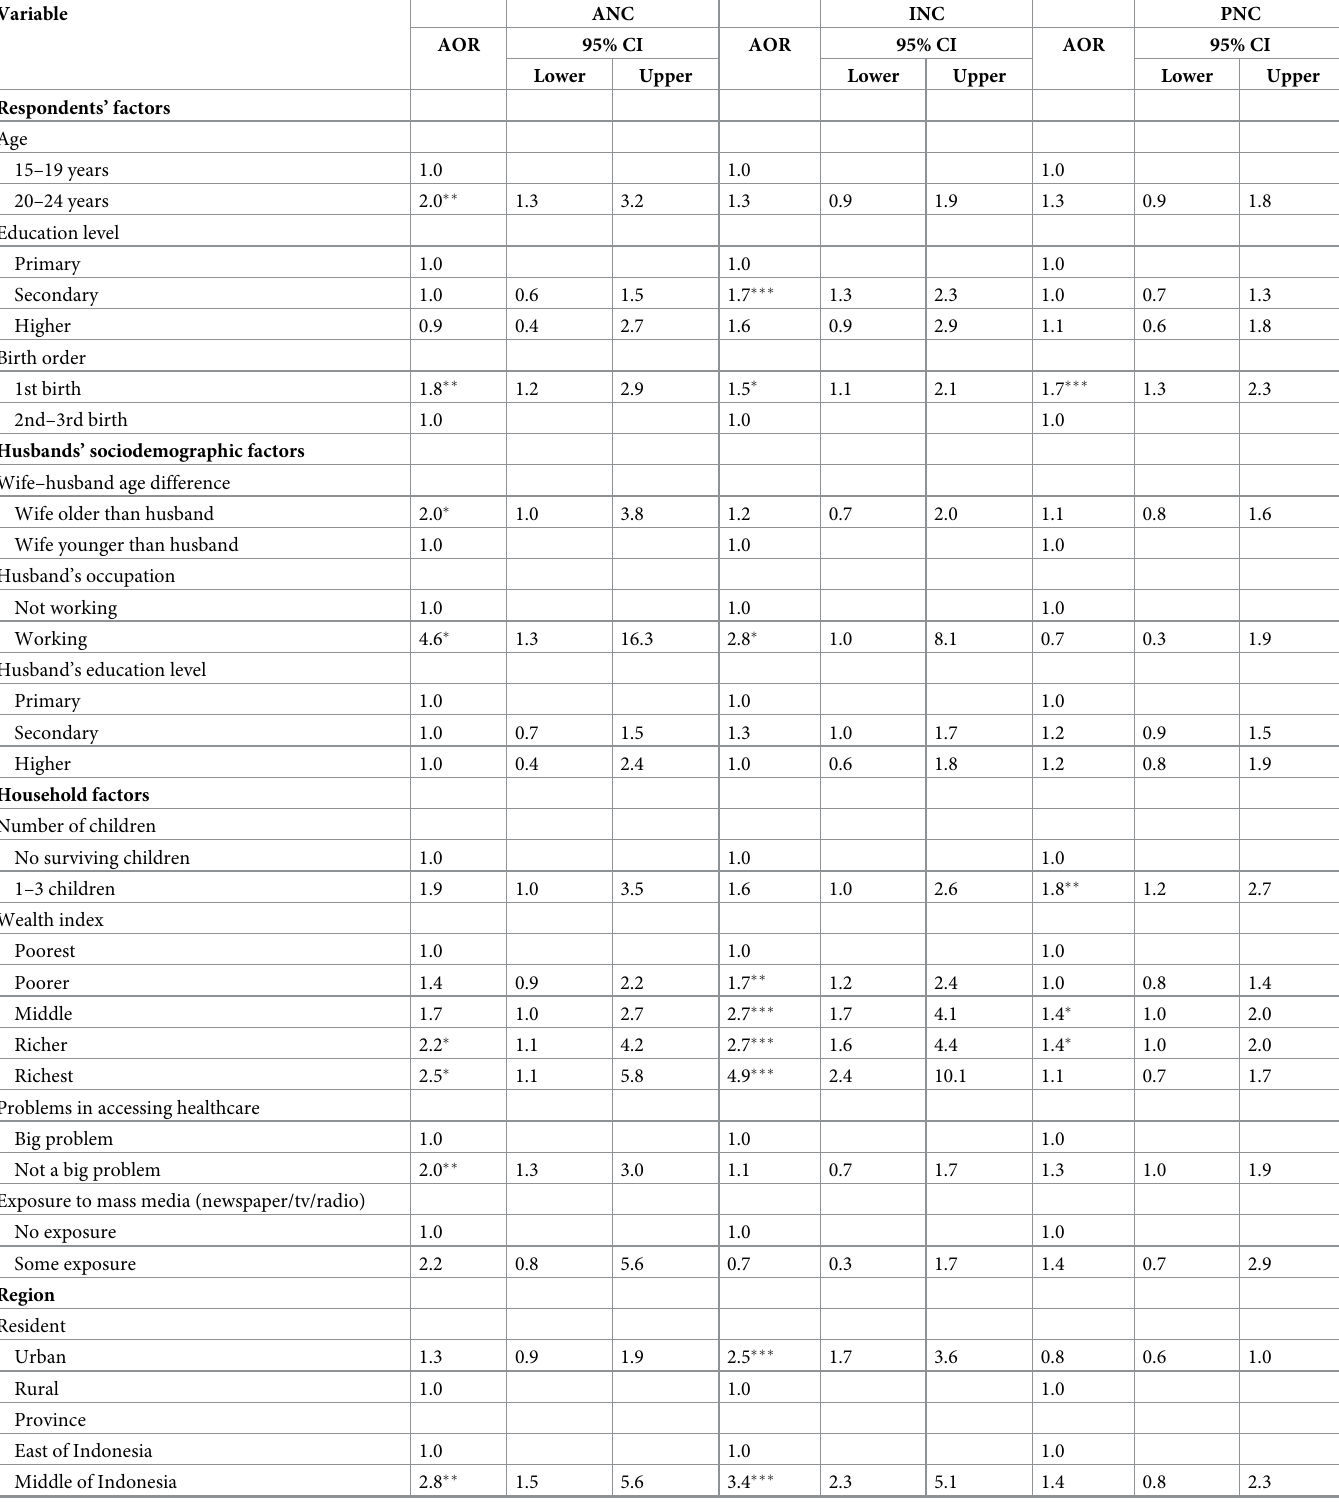
Table 3. Adjusted multiple logistic regression analysis of ANC, INC, and PNC utilization among mothers aged 15–24 years in Indonesia.